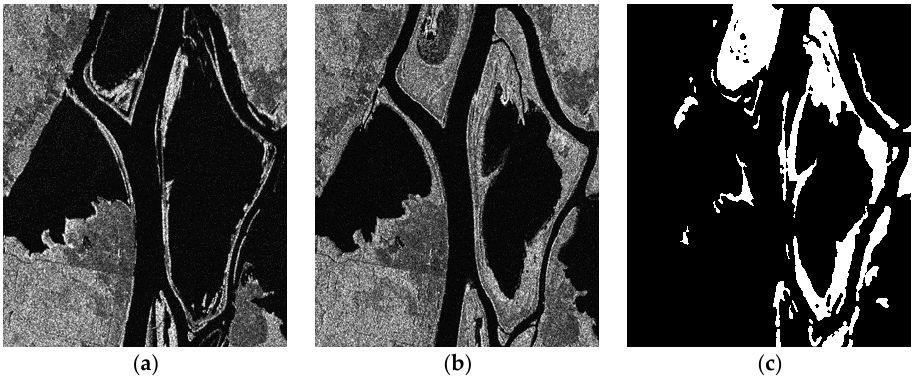
Figure 9. Ottawa dataset. ( a ) Image acquired in May 1997. ( b ) Image acquired in August 1997. ( c ) Ground truth change map created by on-the-spot investigation and expert knowledge.